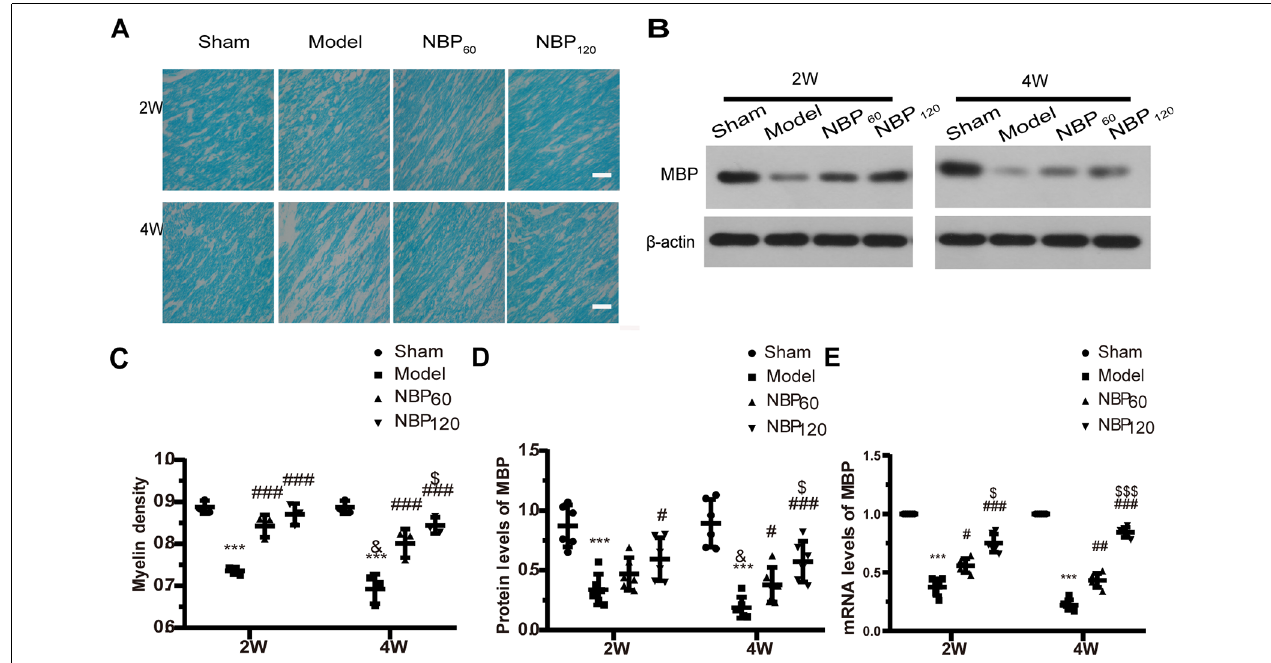
FIGURE 3 | Dl-3-n-butylphthalide (NBP) attenuates demyelination in corpus callosum after 2VO. (A) Representative images of luxol fast blue (LFB) staining in the corpus callosum at 2 weeks and 4 weeks after 2VO. Bar = 50 µ m ( n = 3 in each group). (B) Western blot analysis of the expressions of MBP ( n = 6 in each group). (C) Myelin density in each group presented by the percentage of stained area in total area of corpus callosum. (D) Quantitative analysis of protein levels of MBP. β -actin was used as an internal control. (E) Quantitative analysis of mRNA levels of MBP. β -actin was used as an internal control ( n = 6 in each group). *** p < 0.001, the model group vs. the sham group; # p < 0.05, ## p < 0.01, ### p < 0.001, the NBP 60 group or NBP 120 group vs. the model group; $ p < 0.05, $$$ p < 0.001, the NBP60 group vs. NBP120 group; and & p < 0.05, the model group sacrificed at 2 weeks vs. the model group sacrificed at 4 weeks. Values are expressed as mean ± SD. MBP, myelin basic